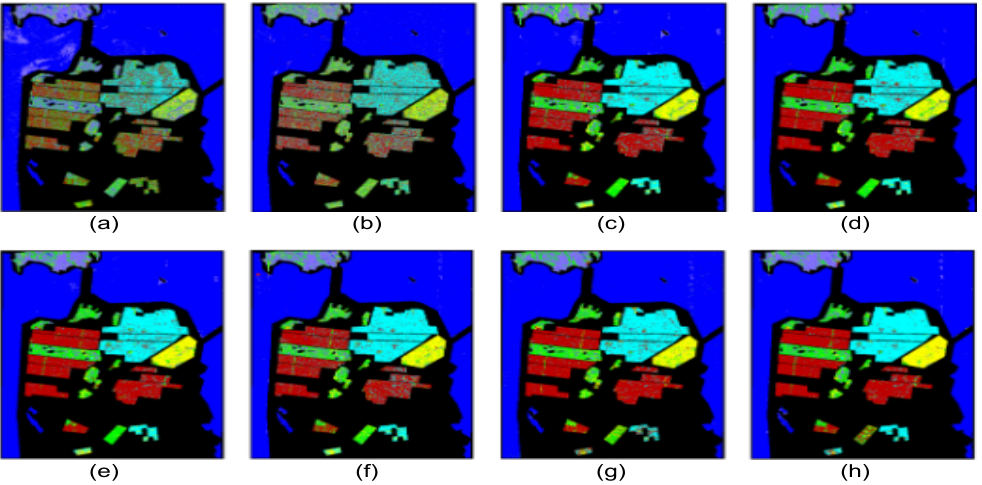
Figure 13. A visual comparison in terms of supervised classification of the entire map on the ALOS2 San Francisco dataset. Here, ( a – h ) shows the results obtained from Wishart, RBF-SVM, CV-CNN, 3D-CNN, PSENet, SF-CNN and ViT-PolSAR, respectively. Figure is from